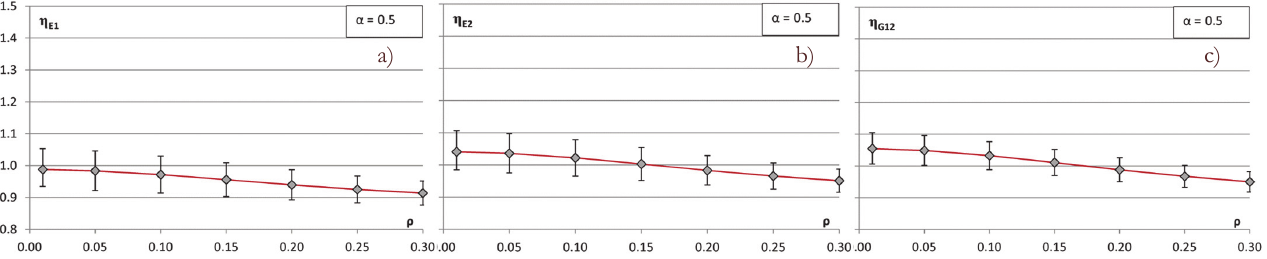
Figure 18: Correction factors vs. relative density for α =0.5: a)  E1,A ; b)  E2,A ; c)  G12,A .